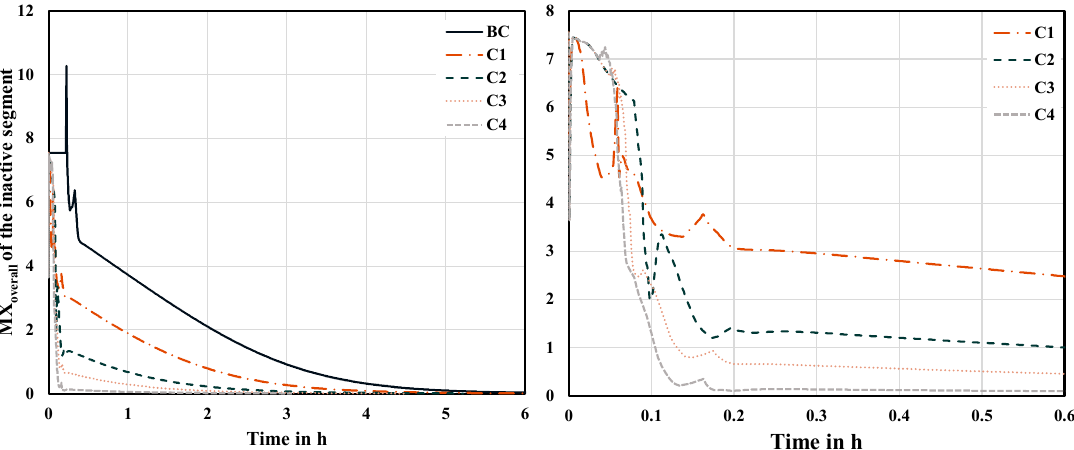
Figure 7. Comparison of the overall MX-functions for all cases in the segmented column ( left ) and zoomed in for cases C1–C4 ( right ).